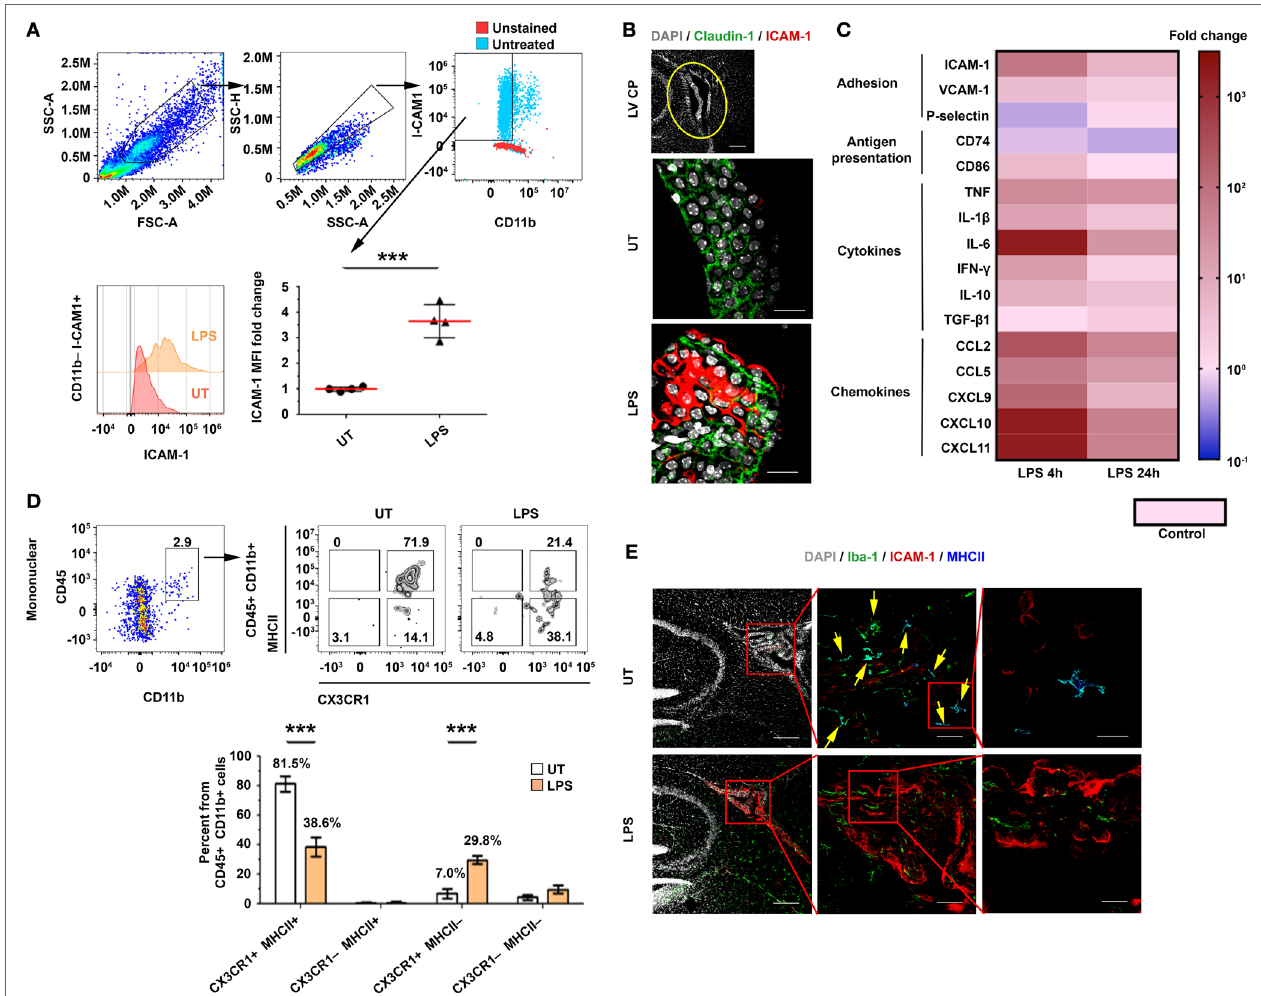
FigUre 1 | An intraperitoneal (IP) injection of lipopolysaccharide (LPS) activates immune signaling in the choroid plexus (CP). Male C57BL/6 mice were preconditioned with an IP injection of LPS (LPS) or of phosphate-buffered saline (PBS) (Control), or were left untreated (UT). The mice were killed 4 or 24 h later, and their lateral ventricle (LV) CPs were either analyzed by immunohistochemistry (IHC) (24 h) or isolated for quantitative PCR (qPCR) (4 or 24 h) and flow cytometry (24 h) analyses. (a) A flow cytometry analysis of the FSC hi SSC hi CD11b − ICAM-1 + cell population and the fold change of the median fluorescent intensity (MFI) of intercellular adhesion molecule 1 (ICAM-1) on CP epithelial cells in LPS-preconditioned mice ( n = 4), as compared with UT mice ( n = 4). Each symbol represents one LV CP from an individual mouse. (B) Representative sagittal brain sections were immunolabeled with anti-Claudin-1 (green) and anti-ICAM-1 (red). DAPI was used for nuclear counterstaining (gray). Sections were then subjected to confocal microscopy and digital image analysis. The z-projection images show a representative LV CP (top panel) and the CP epithelium (green) with an apical expression of ICAM-1 in UT (middle) or LPS-preconditioned (bottom) mice. Scale bars represent 200 µm (top panel) and 20 µm (middle and bottom panels). (c) A heat-map representation (fold change from control) of a qPCR analysis of genes encoding key immune mediators in LV CPs, isolated either 4 h ( n = 5) or 24 h ( n = 7) after they were preconditioned with either LPS or PBS (Control; n = 5). Fold changes and P values are provided in Tables S1A,B in Supplementary Material. (D) A flow cytometry analysis of the CX 3 CR1 and MHCII subpopulations among the CD45 + CD11b + mononuclear cells in LPS-preconditioned mice ( n = 4) and UT wild-type mice ( n = 4). Bars represent means ± SEM. (e) Representative IHC images of LV CPs obtained from the brain sections of UT mice (top), and LPS-preconditioned mice (bottom) immunolabeled with anti-Iba-1 (green), anti-ICAM-1 (red), and anti-MHC II (blue). DAPI was used for nuclear counterstaining (gray). Framed areas are enlarged from left to right. Yellow arrows indicate co-localization of Iba-1 and MHC II. Scale bars represent 200 µm (left), 50 µm (middle), and 10 µm (right). *** P < 0.001 [ (a) unpaired t test; (D) two-way